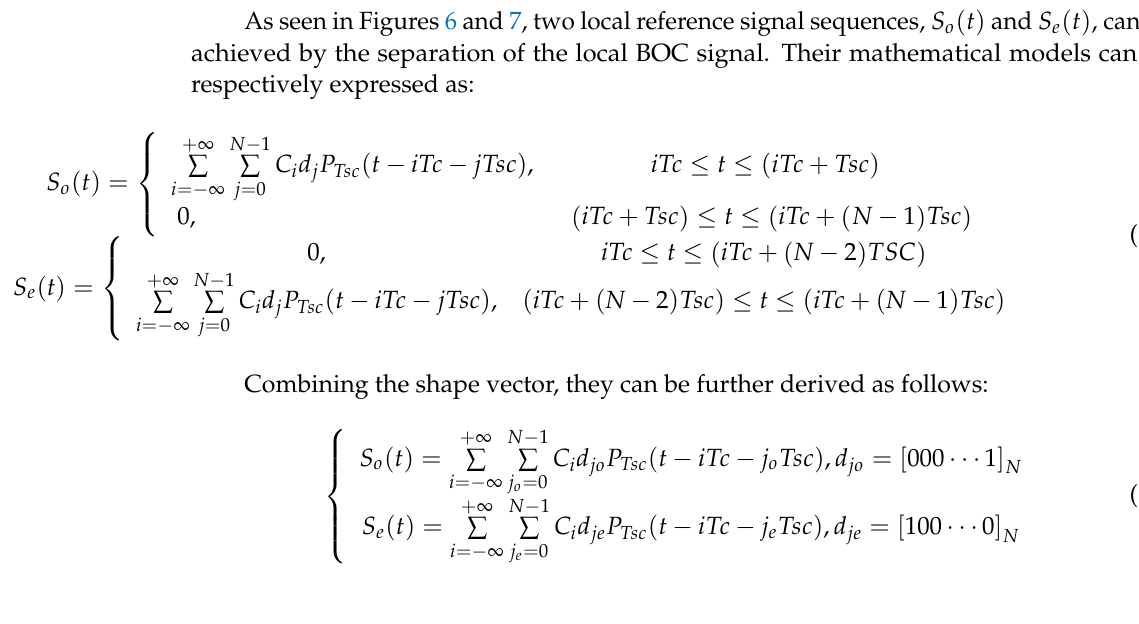
Figure 7. The separation of the BOCs(2,1)